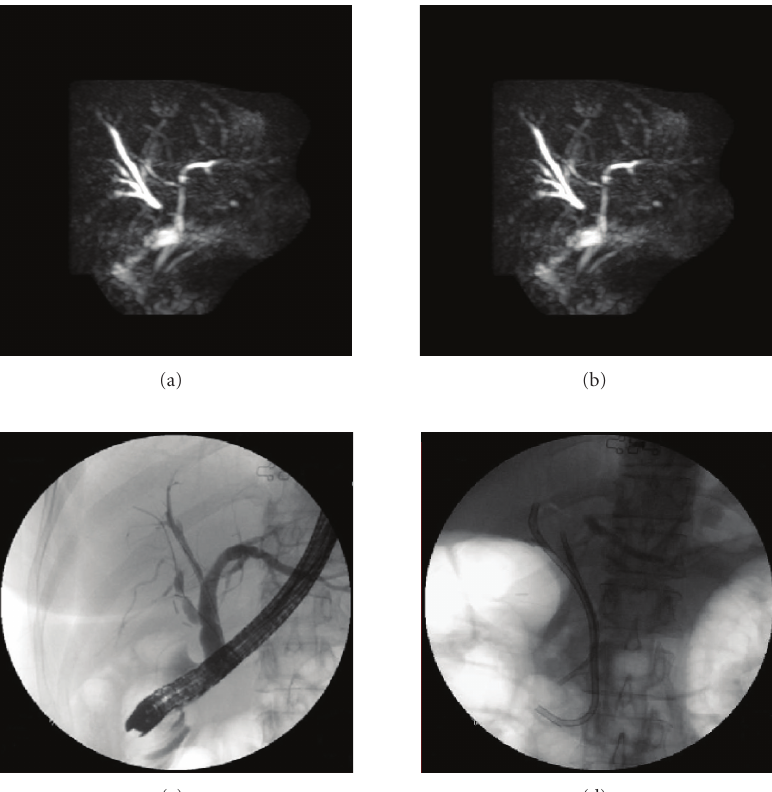
Figure 1: (a) Endoscopic retrograde cholangiopancreatography (ERCP) showing aberrant right hepatic duct filled through cystic duct stump. (b) Magnetic resonance cholangiopancreatography demonstrating dilated intrahepatic ducts in the right lobe of liver. (c) the guidewire placed across the stricture in the aberrant right aberrant bile duct for balloon dilation. (d) Two biliary stents placed-one